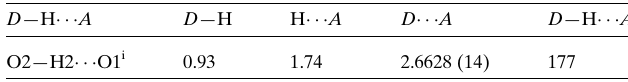
Table 1 Hydrogen-bond geometry (A˚ , (cid:2) ).